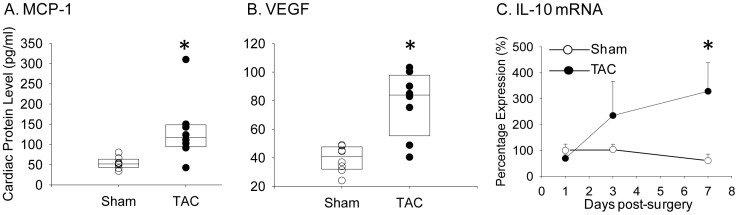
Upregulation of inflammatory markers after TAC in wild-type mice.Levels of MCP-1 (A) and VEGF (B) were measured in homogenized LV at seven days after sham (n = 6) or TAC surgery (n = 8) by Luminex assay. Protein expression (pg/ml) in the homogenate is reported for each individual mouse, and boxes indicated median and 95% CI. (C) RNA was isolated from LV apex at one to seven days after TAC (n = 3–7 per time point). IL-10 mRNA levels were measured by qPCR and values normalized to the sham value at day one, which was set at 100% expression, and presented as mean ± SD. *P<0.05 versus sham.